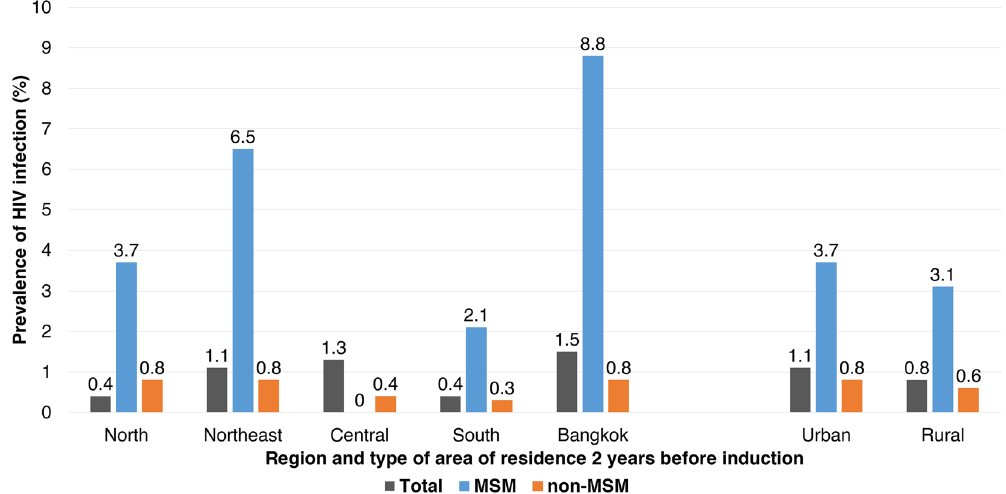
Figure 1. Prevalence of HIV infection among participants by region and type of area (rural vs. urban) of residence 2 years before